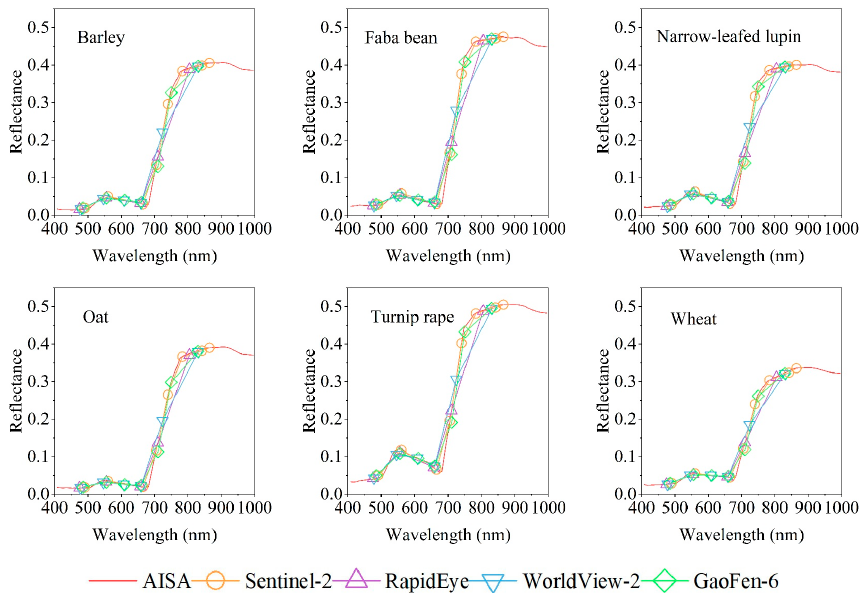
Figure 2. Mean reflectance spectra of the six crop species used in the study: the four simulated sat ‐ ellite broadband spectra and AISA spectra.